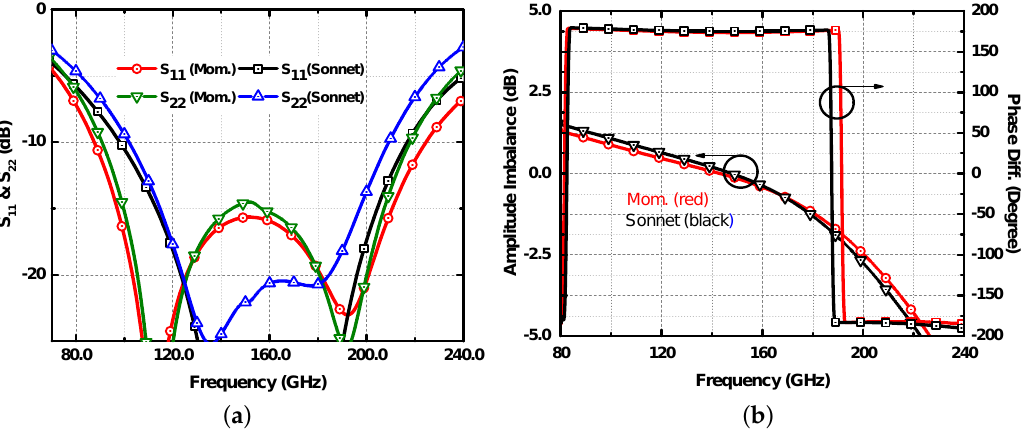
Figure 8. Simulated S 11 , S 22 ( a ) and amplitude imbalance and phase difference ( b ) of the asymmetric coupled line balun in Sonnet and ADS momentum.